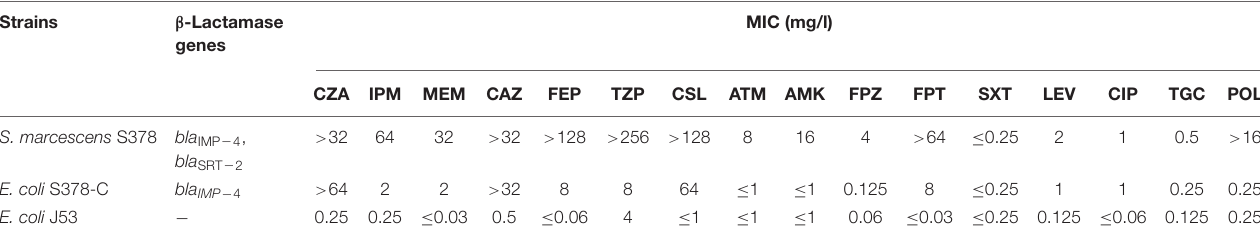
TABLE 1 | Susceptibility of S. marcescens clinical isolate, conjugant and recipient to antimicrobial agents.